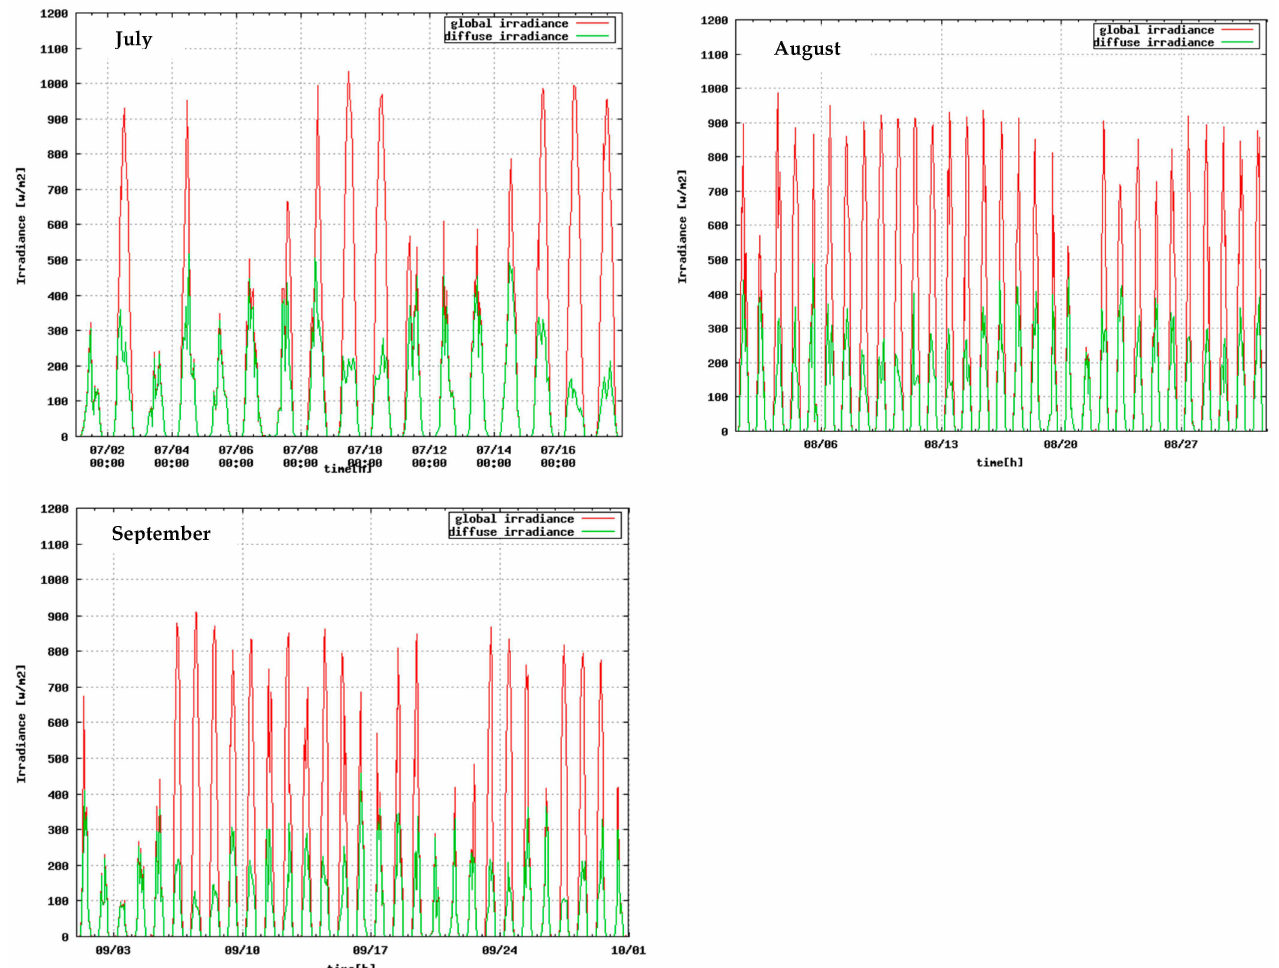
Figure 5. Actual observed solar radiation (diffuse irradiance and global irradiance) from January to September, 2011 in Shanghai, China; please note that the observation that zero values of irradiance in the figures correspond to night